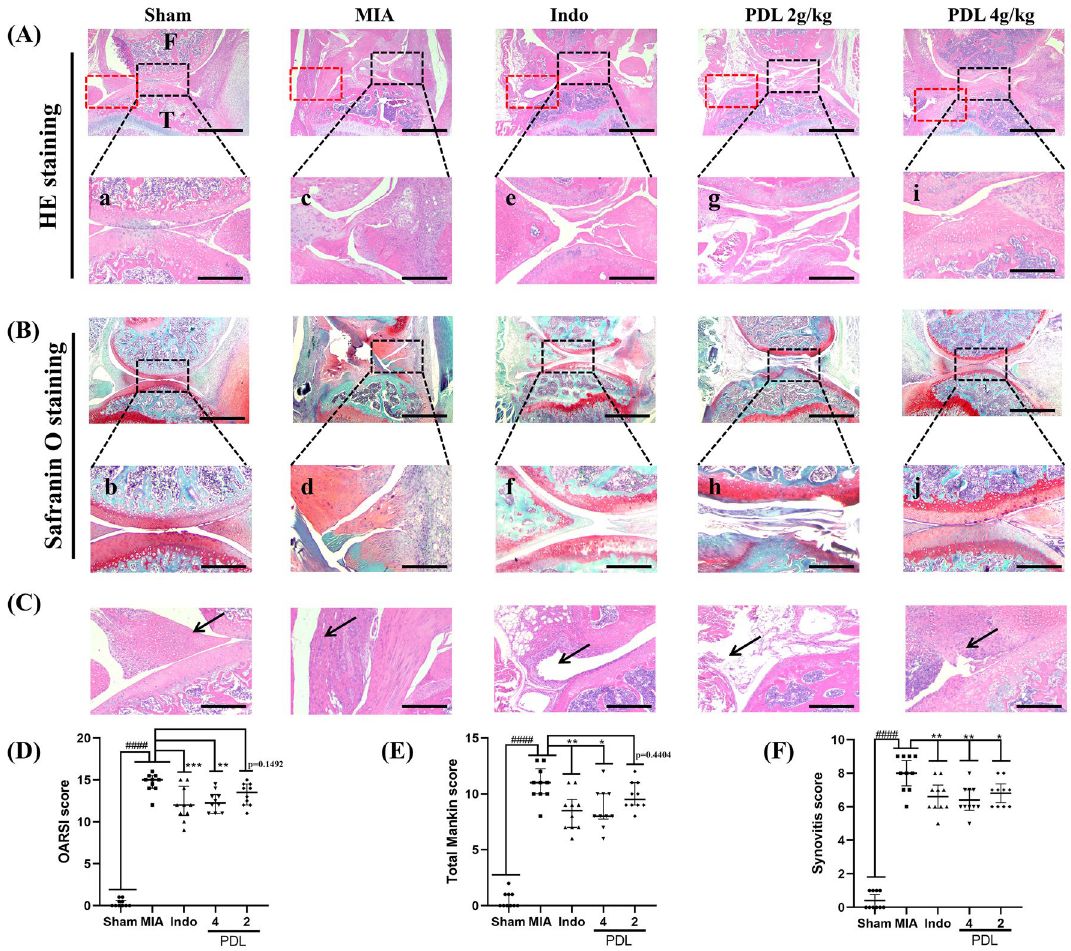
Figure 3. Effect of PDL on MIA-induced pathological changes on the tibiofemoral articular cartilage of the medial tibiofemoral joint. ( A ) Histopathology (H&E stain) of sagittal section (a, c, e, g, i) of tibiofemoral articular cartilage, with femoral condyle at the top and tibial plateau at the bottom. T = tibia. F = femur. Scale bars = 500 µm (upper row), 100 µm (lower row). ( B ) Chondrocytes and proteoglycan layer of tibiofemoral joint stained with Safranin O (b, d, f, h, j). Scale bars = 500 µm (upper row), 100 µm (lower row). ( C ) The synovial membrane with H&E staining from the red dotted box area in ( A ) is shown, and the black arrow indicates the synovial surface. Scale bars = 100 µm. H&E and Safranin O staining sections from each group was used for the assessment of PDL via ( D ) OARSI score, ( E ) modified Mankin score, and ( F ) Severity of synovitis evaluated by Synovotis scores. The data were present as the median with interquartile range. (Two observers contributed scores, n = 5, ####p < 0.0001 compared with the Sham group. *p < 0.05, **p < 0.01, ***p < 0.005 compared with the MIA